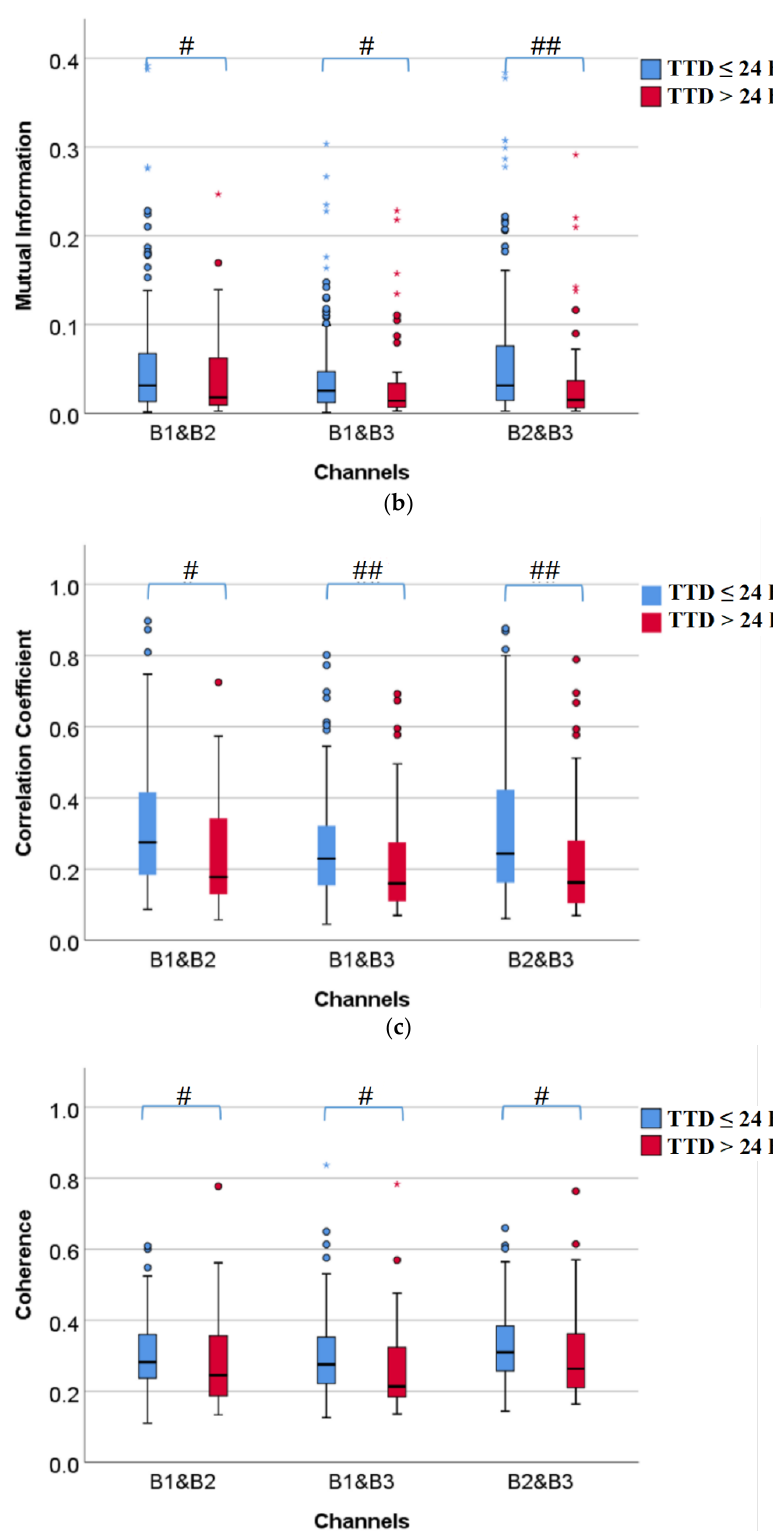
Figure 5. Comparison of coupling information between TTD ≤ 24 h and TTD > 24 h. #: p < 0.05, ##: p < 0.01, ○ : the moderate outlier, *: the extreme outlier. ( a ) Multivariate sample entropy; ( b ) Mutual information; ( c ) Correlation coefficient; ( d ) Coherence.